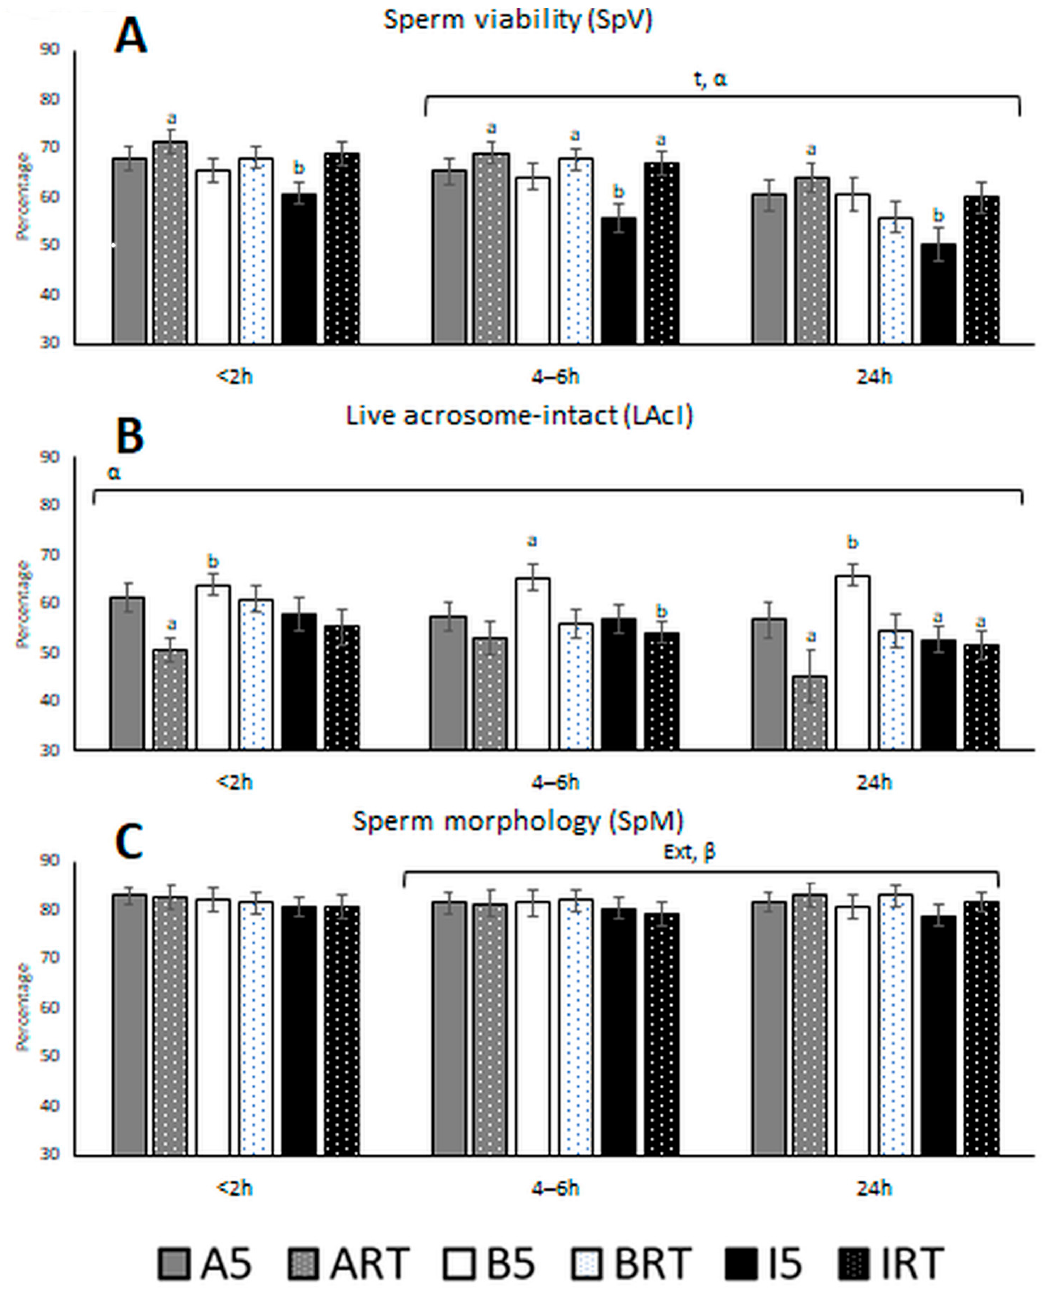
Figure 2. ( A ) Bull sperm viability (percentage), ( B ) live acrosome—intact spermatozoa (percentage), and ( C ) sperm mor- phology (percentage) after storage for three periods in the presence of three extenders at two temperatures. Abbreviations: A: AndroMed ® ; B: BIOXcell ® ; I: INRA96 ® ; RT: room temperature; 5: refrigeration at 5 ◦ C; t: time; Temp: temperature; Ext: extender; α : interaction temperature by extender; β : interaction temperature by time; γ : interaction extender by time; δ : triple interaction temperature by extender by time. Bars with different letters denote significantly different values ( p < 0.05) among the six aliquots of the three extenders by two holding temperatures for each storage duration (analyses of variance (ANOVA)). Bars without letters were not significantly different. Square brackets over the bars highlight significant effects of the individual factor or its interactions with time ( p < 0.05 from the generalised linear mixed model). The brackets cover the time window when the effect was significant, whether from <2 to 4–6 h, 4–6 to 24 h, or <2 to 24 h. Total and progressive motility determined in CASA are summarised in Figure